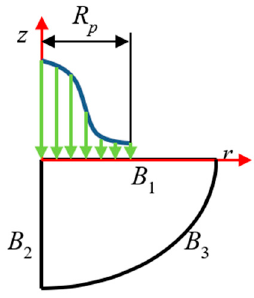
Figure 1. The configuration of the thermal model of micro/nano-EDM. The boundary conditions and initial values of micro/nano-EDM are shown in Equation (10) [23]. B 1 edge: when the r coordinate is smaller than or equal to the radius of the discharge channel ( R P ), the discharge energy q ( r ) will be absorbed by the workpiece. When the r coordinate is larger than the radius of the discharge channel ( R P ), the thermal energy is diffused outward by convection. h c is the convective heat transfer coefficient, ∆ Q is the heat flux, and the T ref is the ambient temperature. B2 edge is an axisymmetric side. The heat flux on the B2 edge is 0. In the simulation model, the lengths of the B1 edge and B2 edge are 1000 times the length of the radius of the discharge channel ( R P ). Then, the B3 edge can be considered an open boundary. The heat flux on the B3 edge is 0. The initial temperature of the workpiece is the same as the ambient temperature.